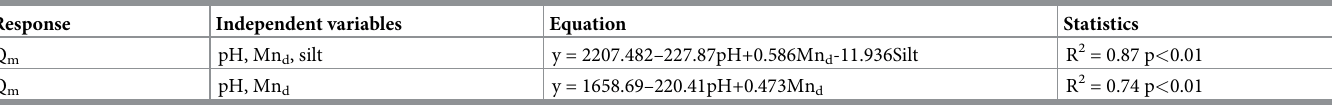
Table 5. Multiple regression formulae describing the relationship between soil properties and P sorption maxima for 11 vegetable-cultivated soils � .